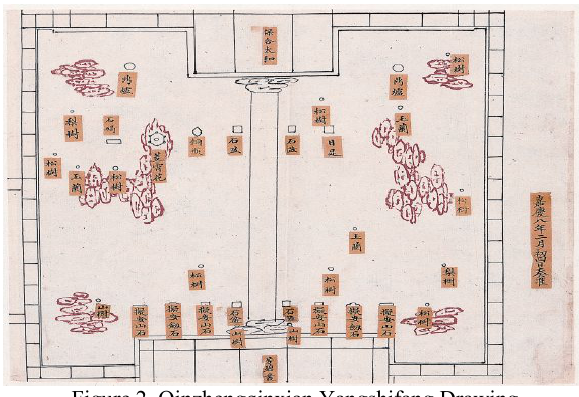
Figure 2. Qinzhengqinxian Yangshifang Drawing